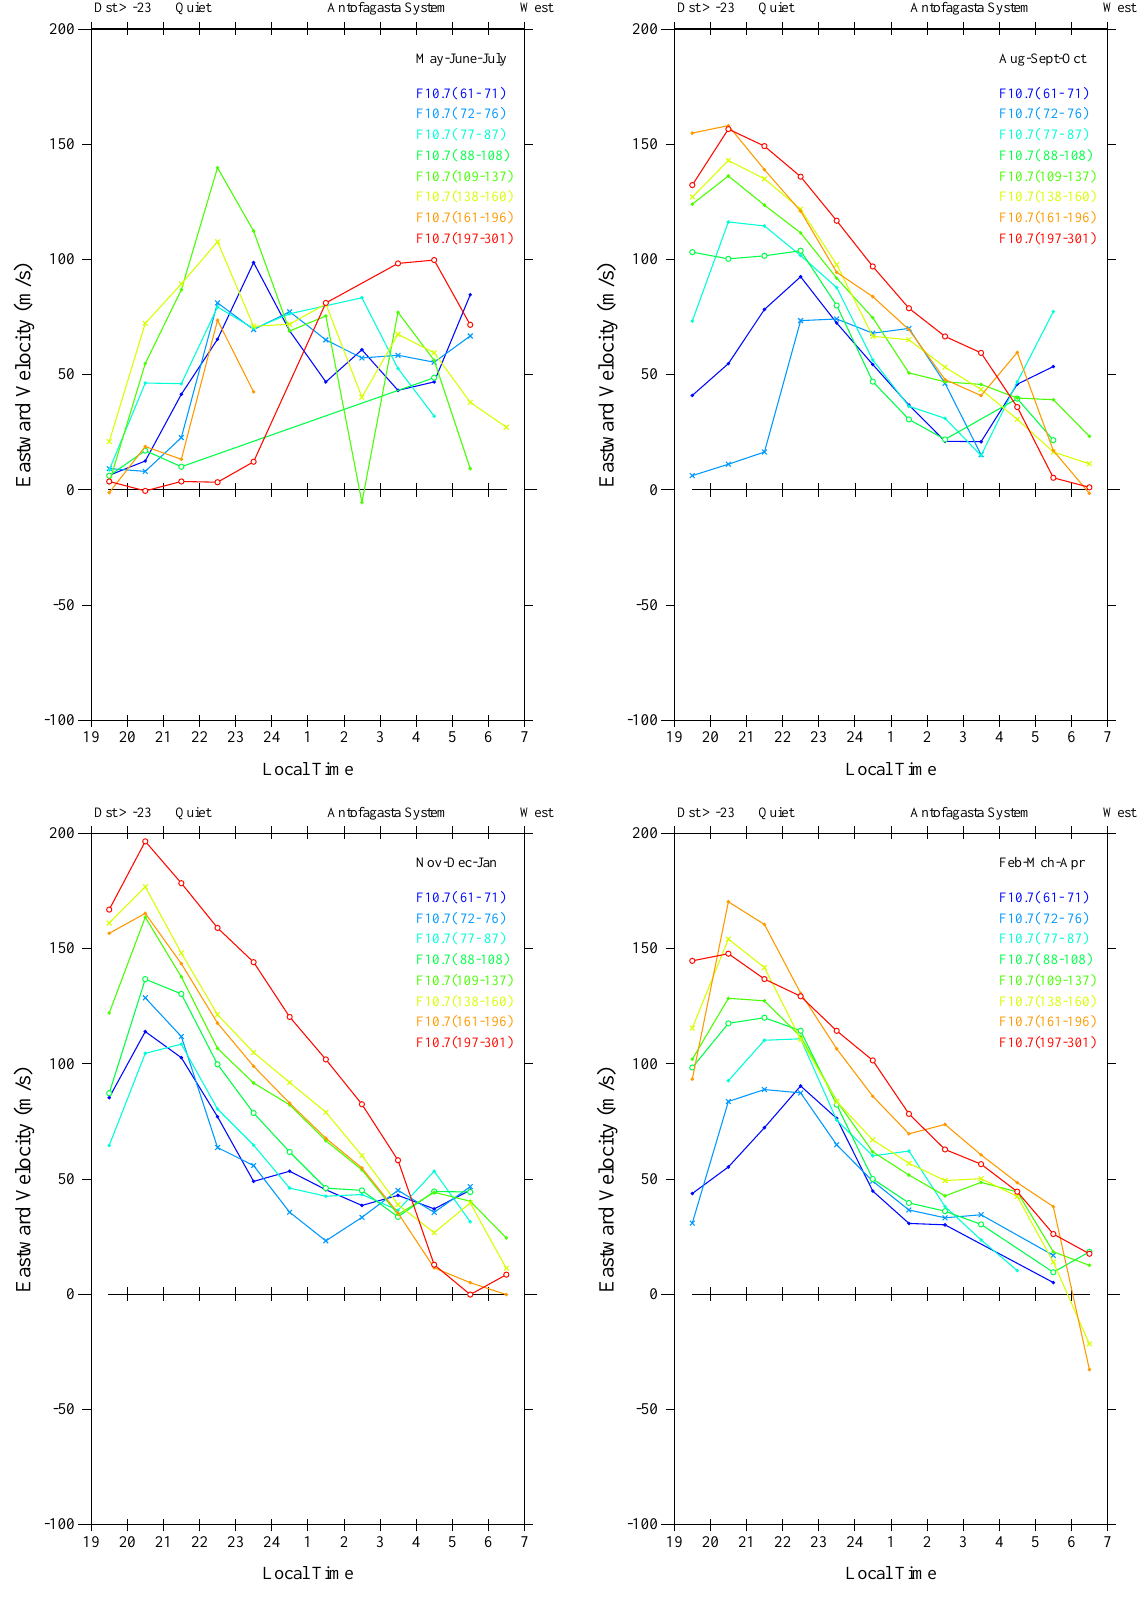
Fig. 4. Seasonal average zonal drifts for